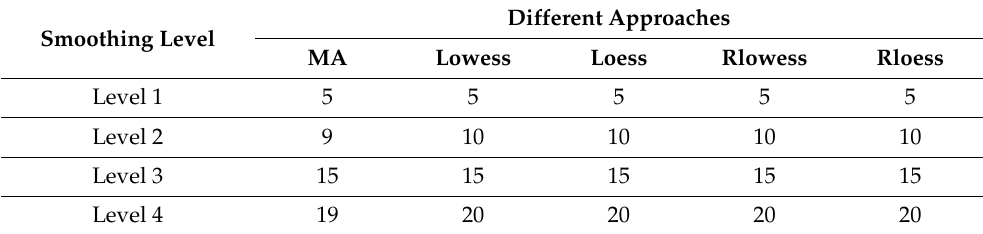
Table 2. Parameters sets of the span of different smooth